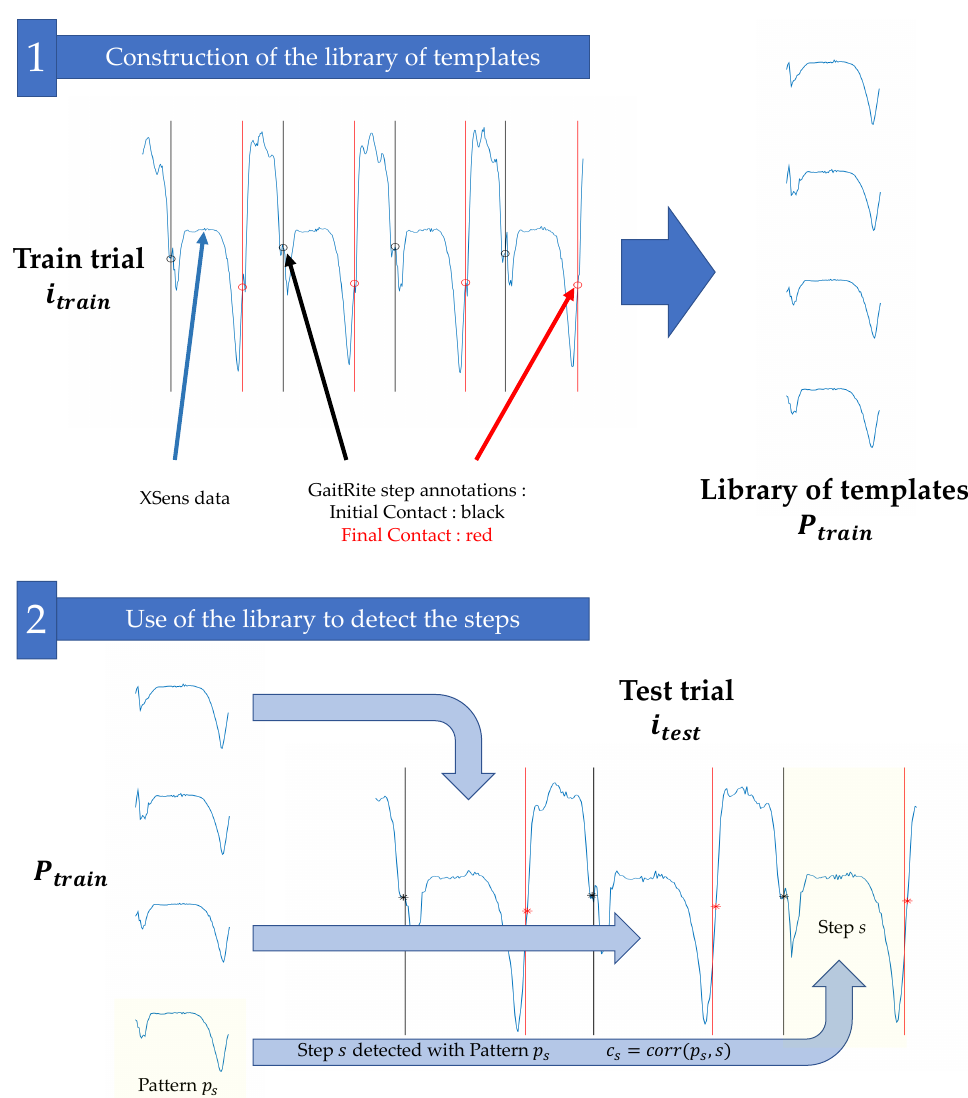
Figure 2. Main stages for the computation of the similarity index (SId). First, the GR and XS data from the trial i train are used to build a library of templates P train . In the second stage, the library is used to detect the steps in the trial i test , according to a greedy template-based approach inspired by [44]. Each detected step s is associated with one template p s . The correlation coefficients c s between